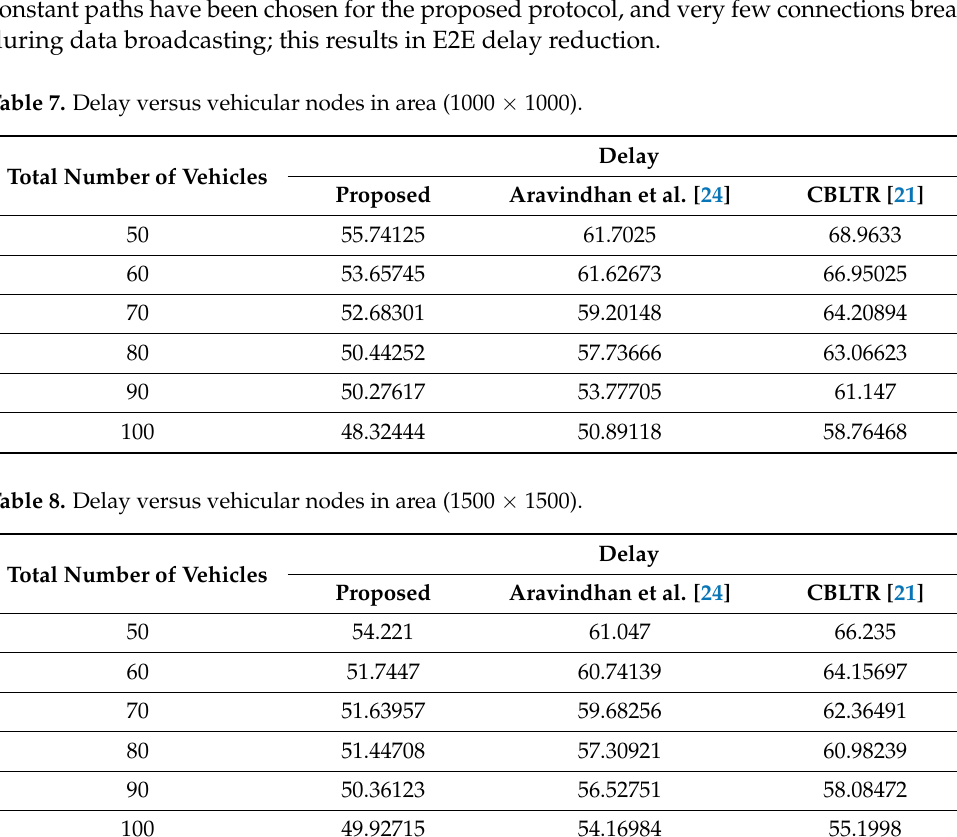
Figure 8. Comparison of results of the proposed system and existing systems (Aravindhan et al. [24] and CBLTR [21]) on PDR versus vehicular nodes in 1500 × 1500.